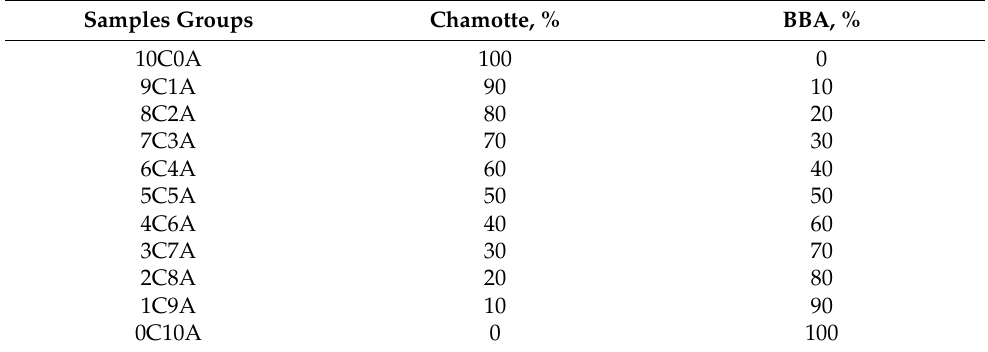
Table 1. Sample groups composed of geopolymers with different combination percentages of chamotte and biomass bottom ash